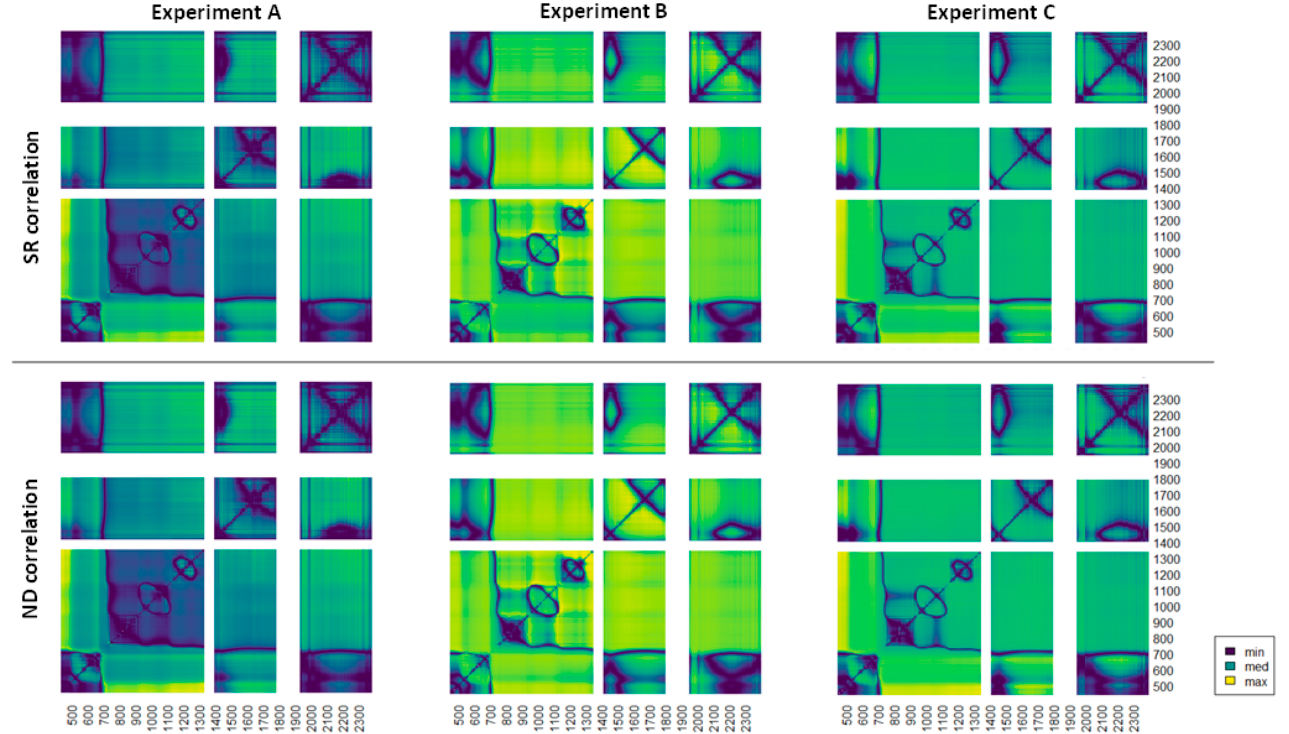
Figure 5. Coefficient of determination Heatmaps between calculated vegetation indices (VIs) (both Simple Ratios, SR, and Normalized Difference, ND) vs. nitrate content ([Nitrate]) for each experiment (Exp. A, Exp. B, and Exp. C; see Table 1 for further details). White bands correspond to the bands which have been removed from the database because of significant atmospheric effects.